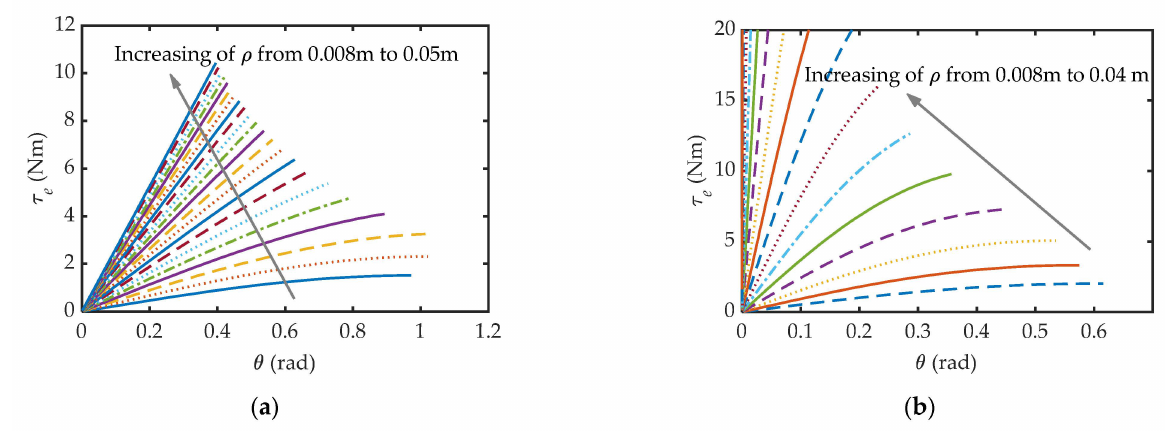
Figure 5. Stiffness characteristic and variation of output torque: ( a ) configuration I: low stiffness with limited range ( AB > OA ); ( b ) Configuration II: infinite stiffness range ( AB < OA ).